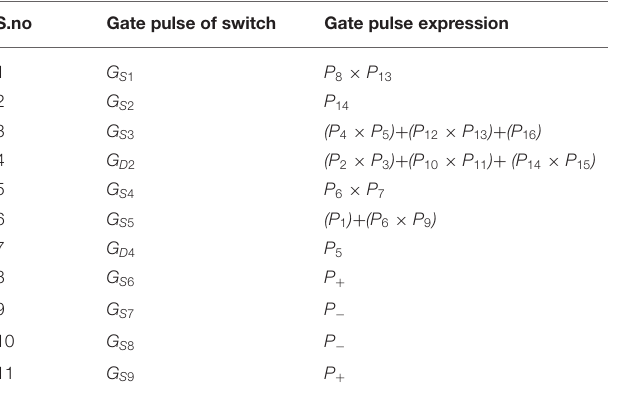
TABLE 3 | The comparison of proposed seventeen level inverter topology with the existing MLI topologies.